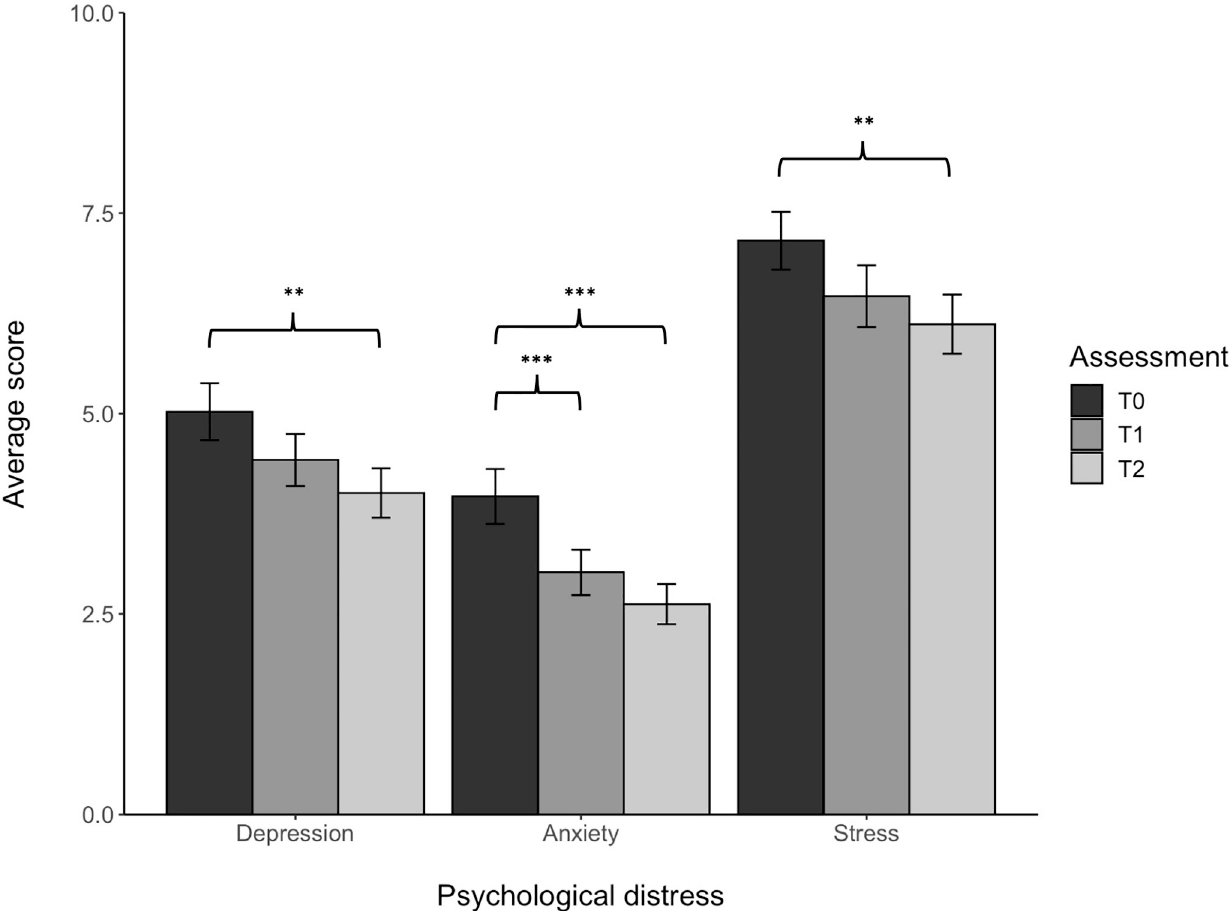
Fig 3. Depression, anxiety and stress over time. As a measure of dispersion, error bars are shown.